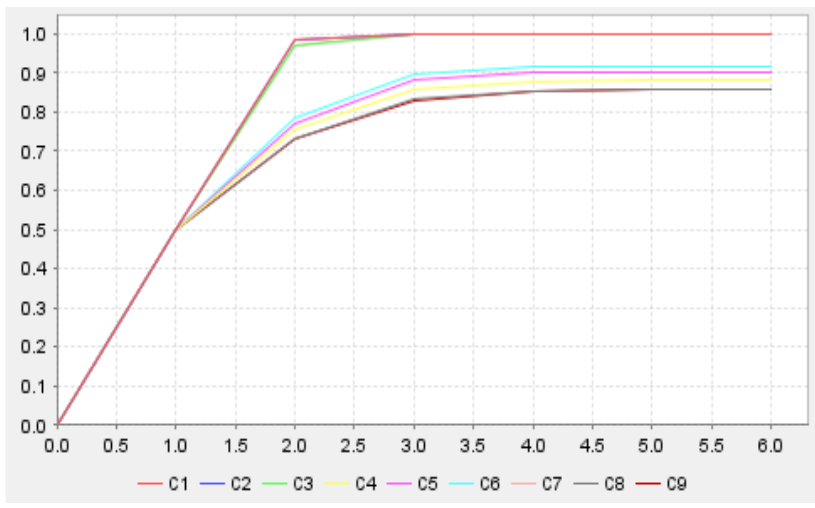
Fig. 4. FCM of P&S inference process.